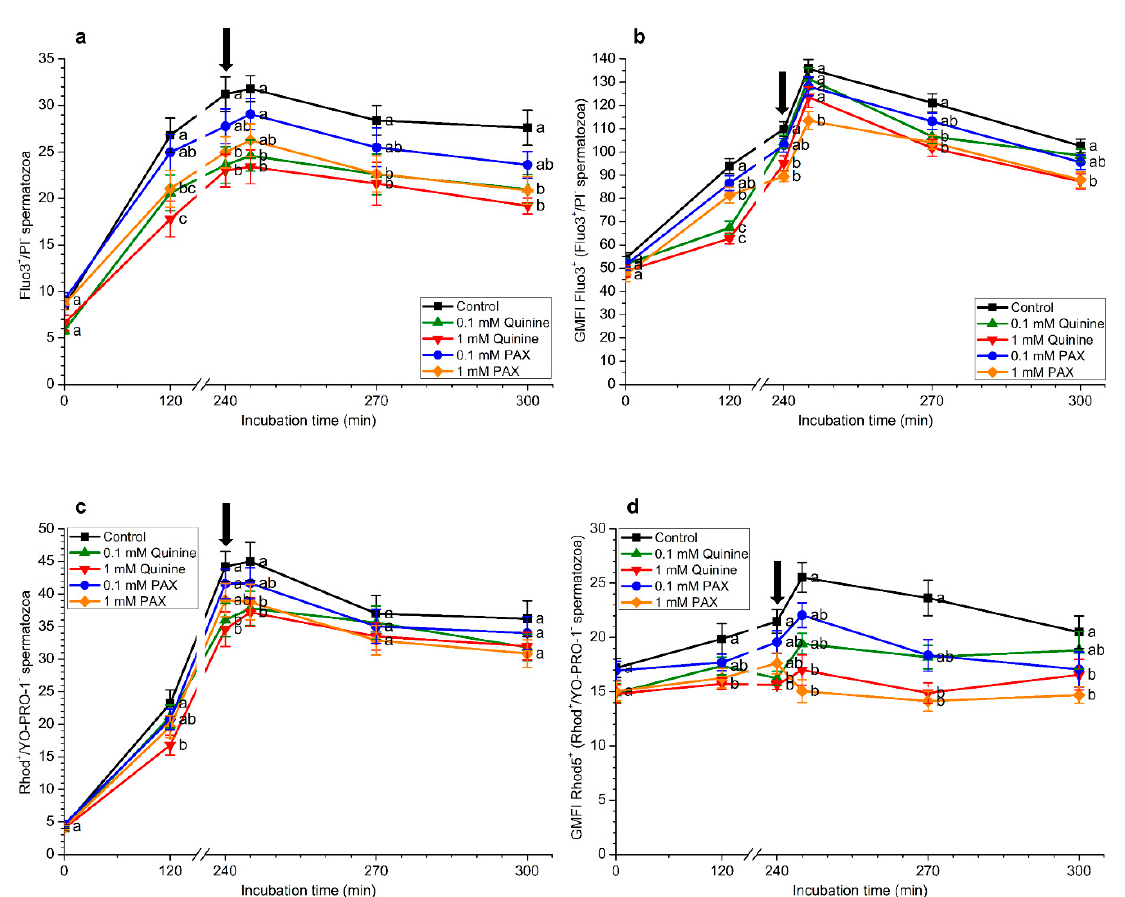
Figure 3. ( a ) Percentages of viable spermatozoa with high intracellular calcium levels evaluated with Fluo3 (Fluo3 + /PI − ), ( b ) geometric mean of fluorescence intensity (GMFI) of Fluo3 in Fluo3 + /PI − sperm population, ( c ) percentages of viable spermatozoa with high intracellular calcium levels evaluated with Rhod5 (Rhod5 + /YO-PRO-1 − ) and ( d ) geometric mean of fluorescence intensity (GMFI) of Rhod5 in Rhod5 + /YO-PRO-1 − sperm population during in vitro capacitation and progesterone-induced acrosomal exocytosis (300 min) in the presence of 0.1 mM quinine, 1 mM quinine, 0.1 mM paxilline (PAX), and 1 mM PAX. Black arrow indicates the time at which 10 µ g/mL progesterone was added to induce acrosomal exocytosis (i.e., 240 min). Different letters (a,b) mean significant ( p < 0.05) differences between treatments at a given time point. Data are shown as mean ± SEM for 15 independent experiments.